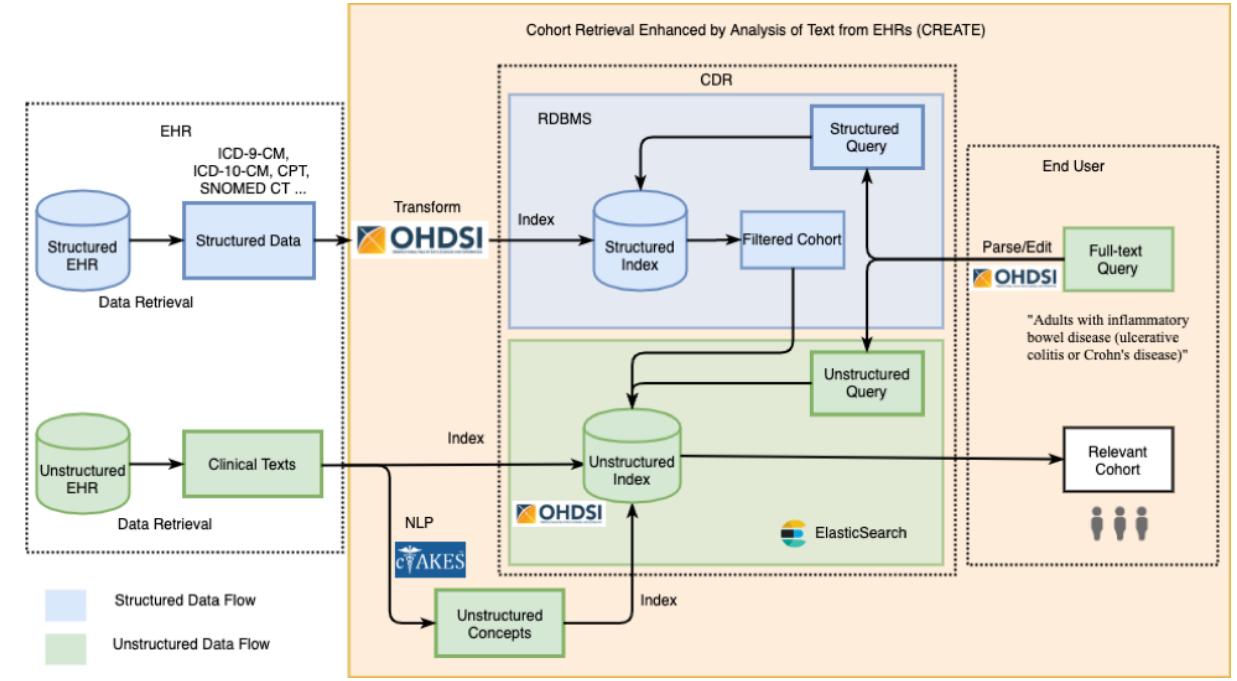
Figure 1. Overview of CREATE’s workflow. CDR: clinical data repository; CM: clinical modification; CPT: current procedures terminology; EHR: electronic health record; ICD: International Classification of Diseases; NLP: natural language processing; OHDSI: Observational Health Data Sciences and Informatics; RDBMS: relational database management